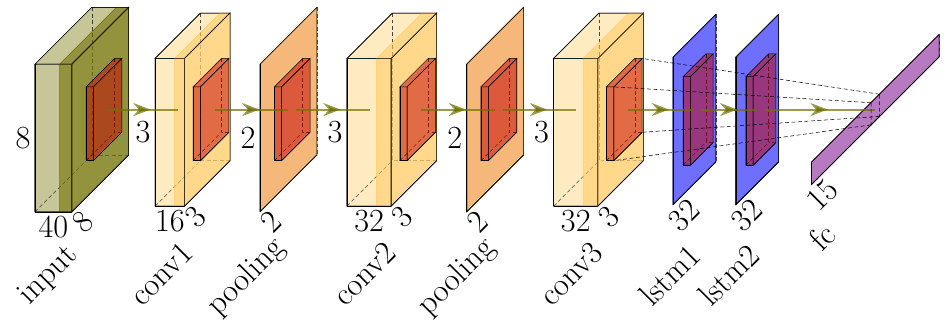
Figure 11. Illustration of the CNN-LSTM